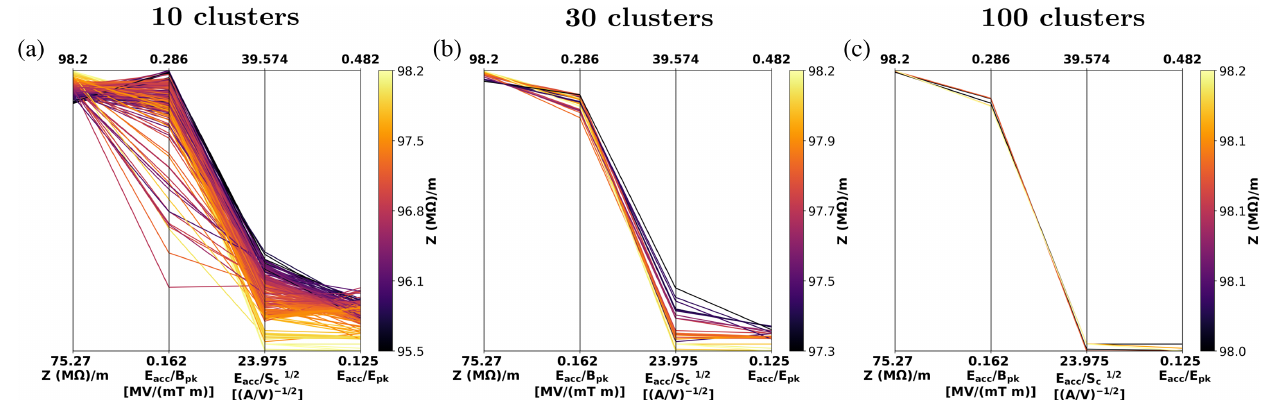
FIG. 14. Three PCPs showing the objective values inside of a single cluster for different numbers of total clusters: (a) 10, (b) 30, and (c) 100 clusters. The opened clusters are the ones with the highest value of Z